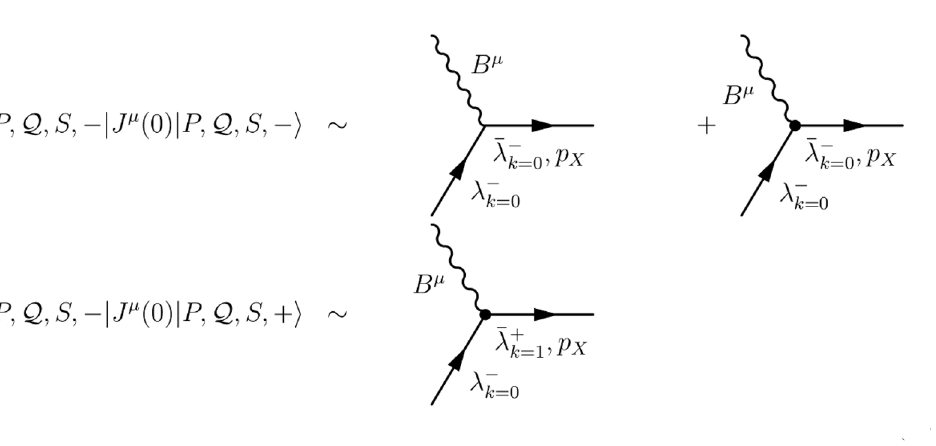
Figure 2 . On the left we write the matrix elements of the electromagnetic current inside the hadron. On the right we draw the corresponding holographic dual Feynman diagrams. The diagram in the second line shows an example of the λ −